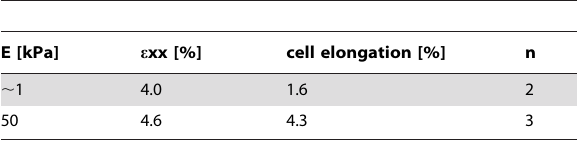
Table 4. Influence of substrate stiffness on cell property during